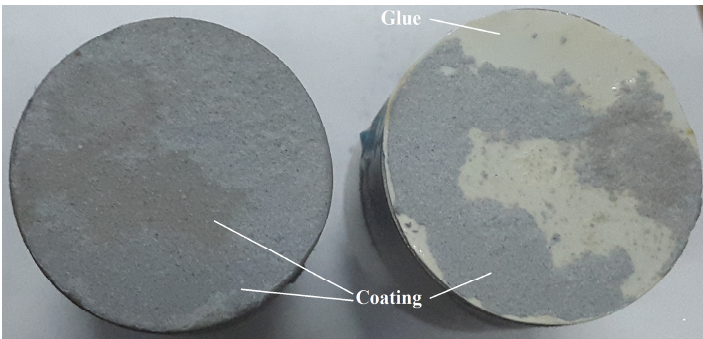
Figure 9. Macrograph of fractured surface after tensile strength test.